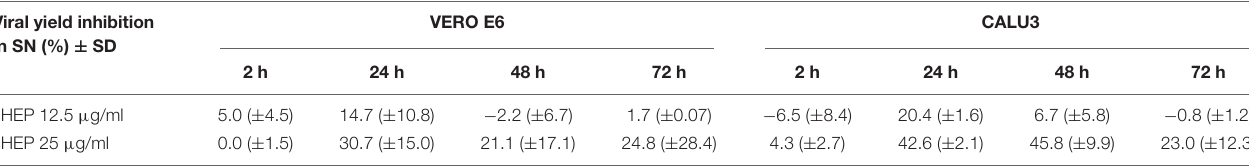
FIGURE 4 | Effects of sHEP on SAR-CoV-2 yield in SNs of VERO E6 and CALU3 cell lines. Panels (A,B) SARS-CoV-2 titration (Log TCID 50 /mL) in SNs of VERO E6 and CALU3, respectively, after infection and culturing in presence of 12.5 or 25 µ g/mL sHEP or medium alone was measured at indicated time points. Data represent the mean (+SD) of three independent experiments. Virus titration was performed on VERO E6 cell line by limiting dilution assay; the viral titer was calculated using the method of Reed and Muench and expressed as tissue culture infectious dose TCID 50 /mL. The asterisks indicate statistically significant differences determined by Student’s t -test (***, p < 0.001, **, p < 0.01; * p < 0.05; no asterisk, p ≥ 0.05) between Infected cells and those infected and cultured in presence of sHEP. TABLE 2 | Viral yield inhibition in SNs (the viral yield inhibition in SNs was induced by adding sHEP in culture medium after virus inoculation was calculated from ORF1ab gene Ct